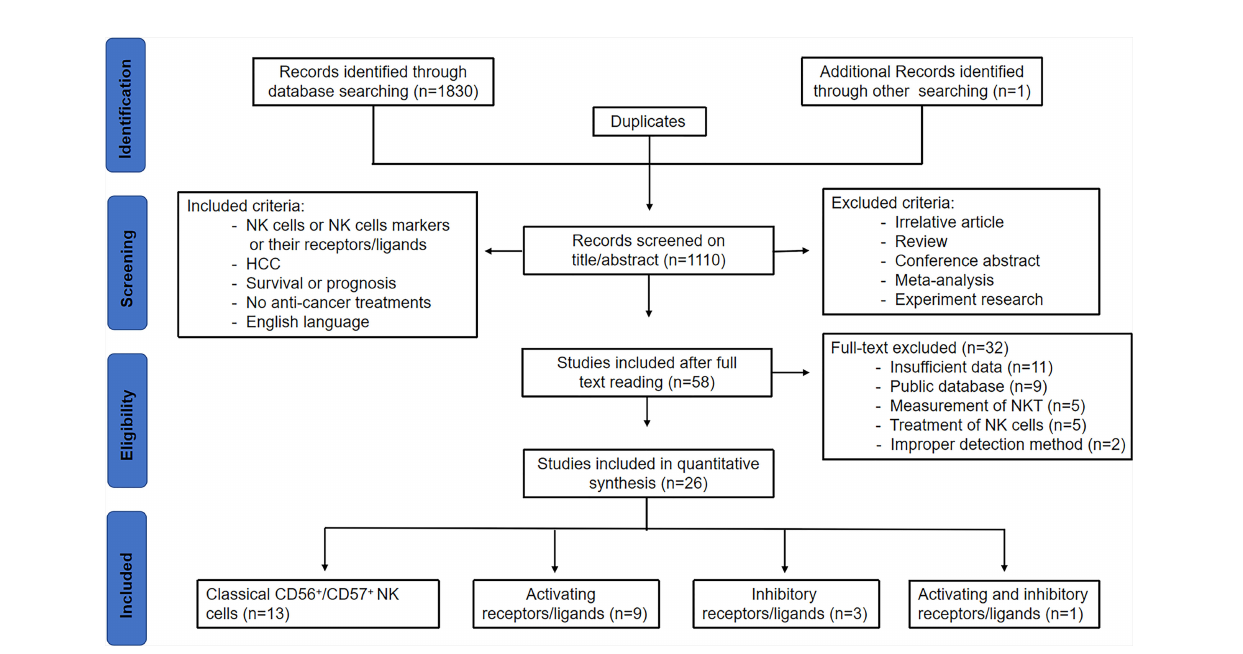
FIGURE 1 | Study fl ow chart of the data extraction process and selection of studies for